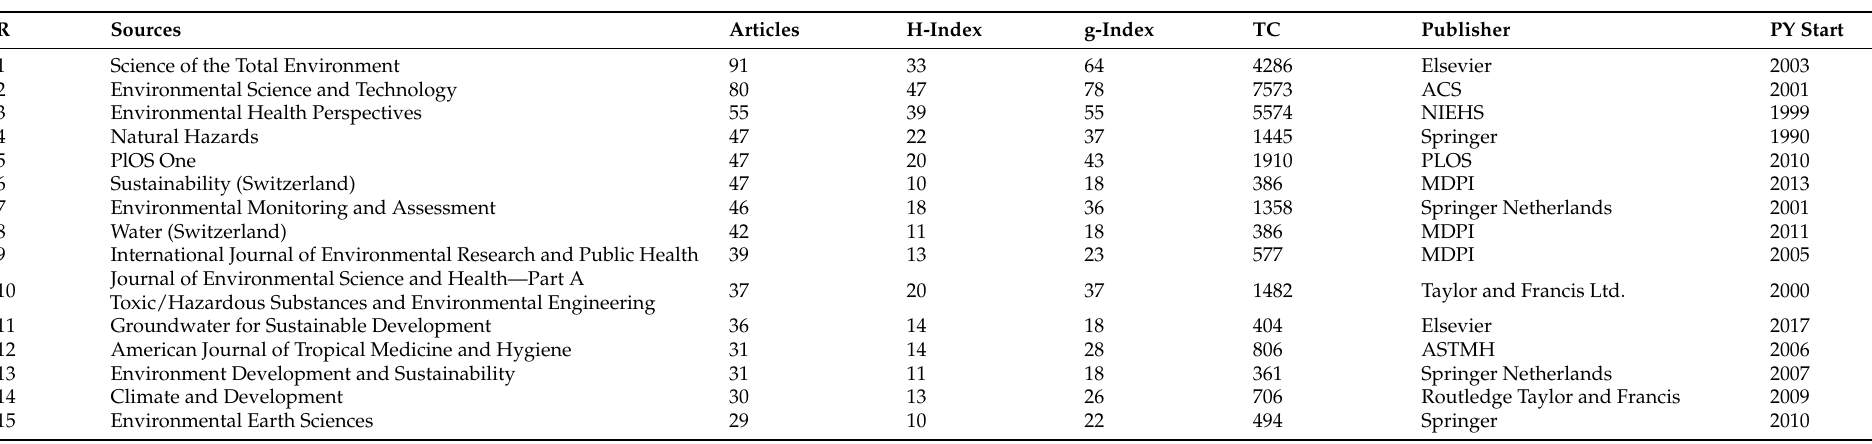
Table 5. Top 15 productive journals in Bangladesh water-research-related publications (Note: R is the rank based on the number of publications. TC is total citations. PY start is the year of first publication).